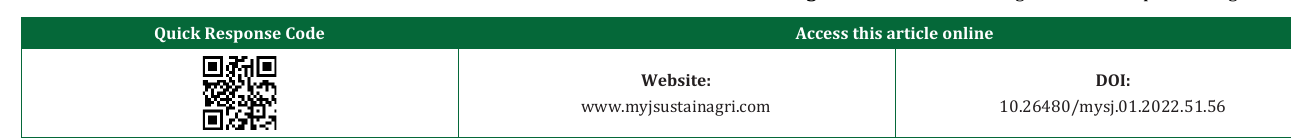
Figure 1: Color of the mangosteen development